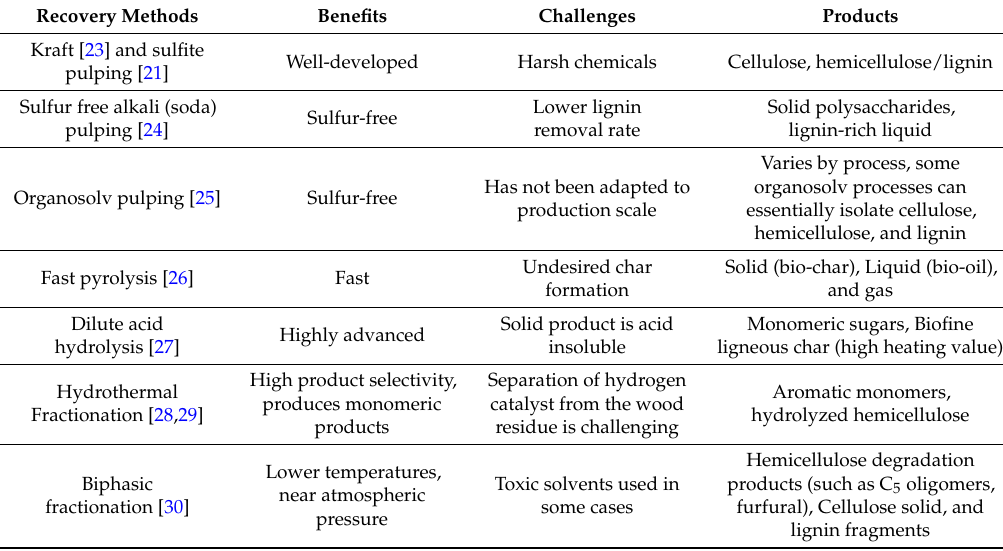
Table 2. Non-biological lignin recovery